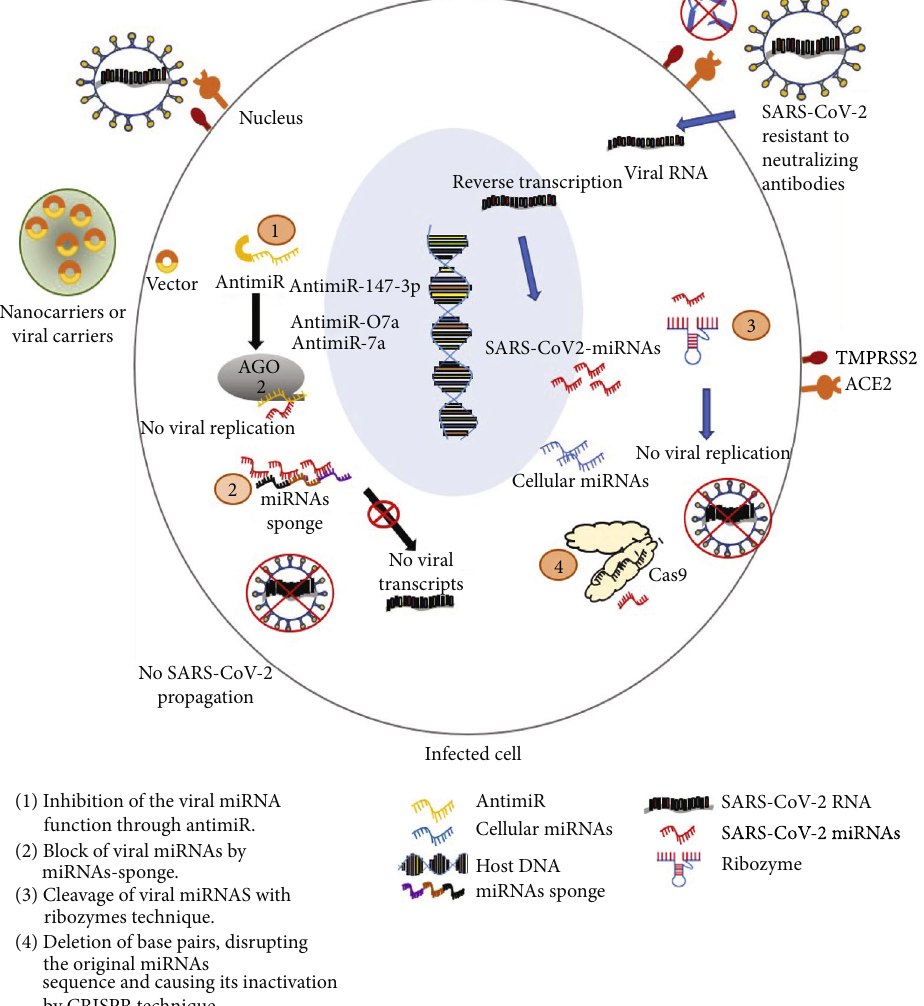
Figure 3: Targeting viral miRNAs for therapeutic avenues. 1 — inhibition of the viral miRNA function through antimiR; 2 — blocking of viral miRNAs by miRNA sponge; 3 — cleavage of viral miRNAs with ribozyme technique; 4 — deletion of base pairs, disrupting the original miRNA sequence and causing its inactivation by CRISPR technique. Abbreviations: ACE2: angiotensin-converting enzyme; AGO2: argonaute 2; CRISPR: clustered regularly interspaced short palindromic repeats; TMPRSS2: transmembrane protease serine